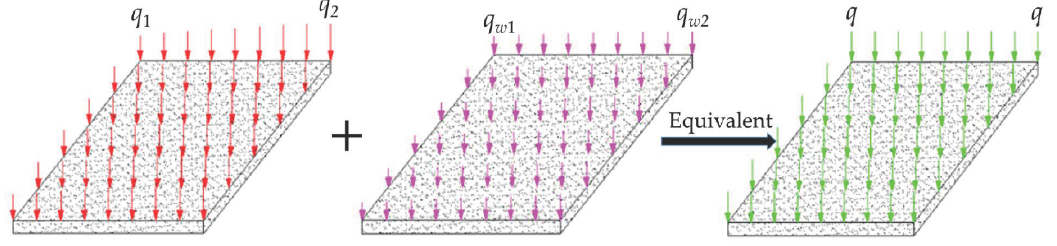
Figure 4. Equivalent force on the back of the concrete retaining wall